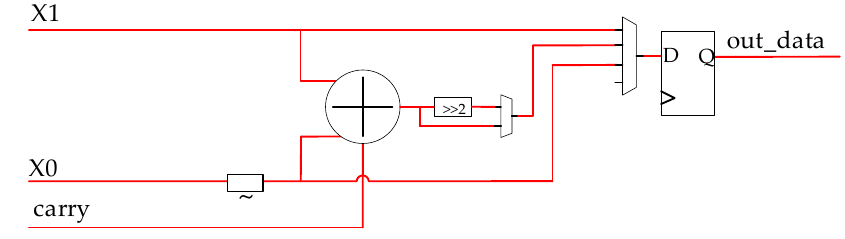
Figure 8. Data transmission of the pooling operation in PE.